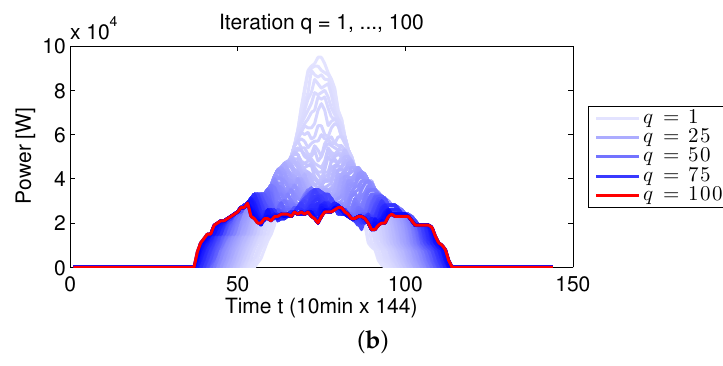
Figure 5. Aggregated profiles. ( a ) Obtained power profiles for various DR price signals; ( b ) Evolution of the aggregated coordination profiles. Note that the best case of price-based DR has a peak consumption of 6 kW, while for coordination the peak consumption is 3 kW.